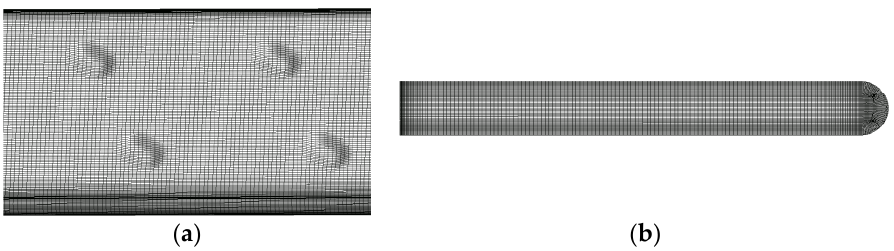
Figure 3. Mesh independence verification at R32 case in the stream-wise direction ( a ) and transver- sal surface ( b ).